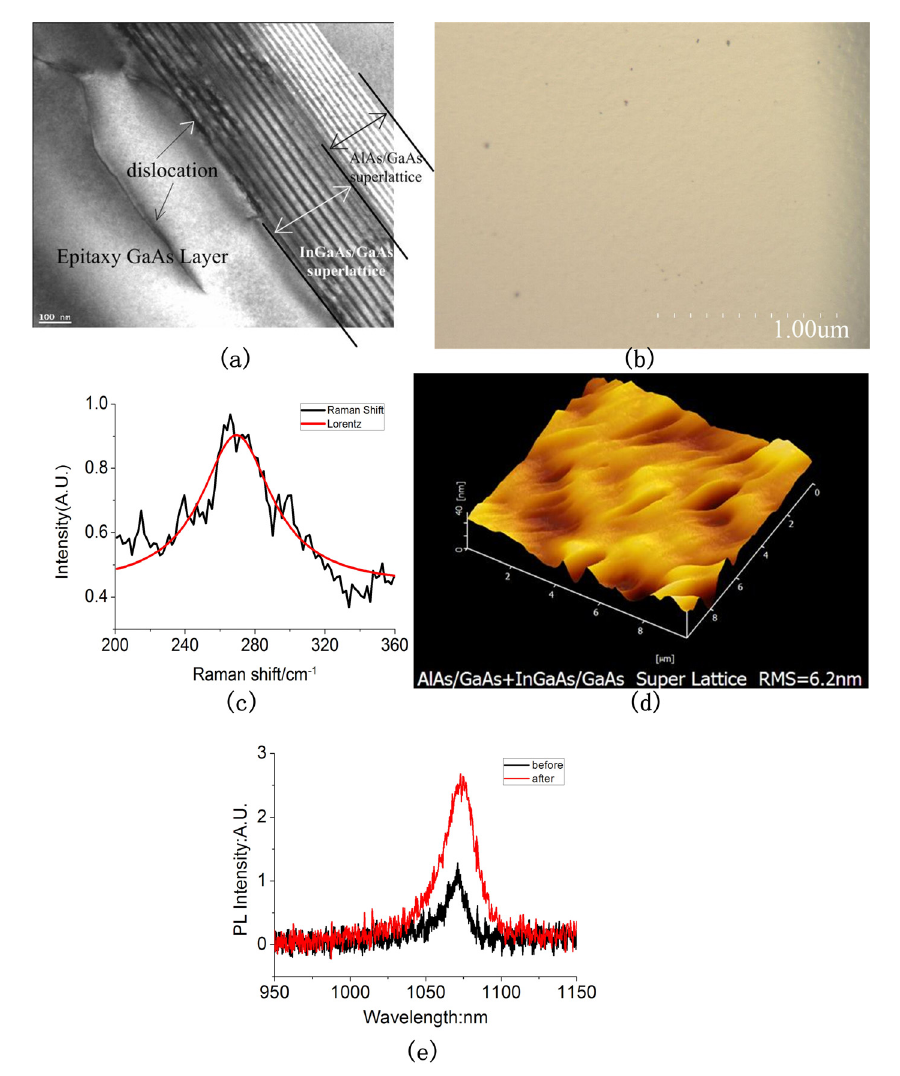
Figure 4. ( a ) The cross-section TEM image of material optimized by strain SL structure; ( b ) The SEM image of EPD after optimized material; ( c ) Raman spectra measured of optimized material using Lorentz fit; ( d ) The AFM image of optimized material; ( e ) The PL spectra measured of optimized